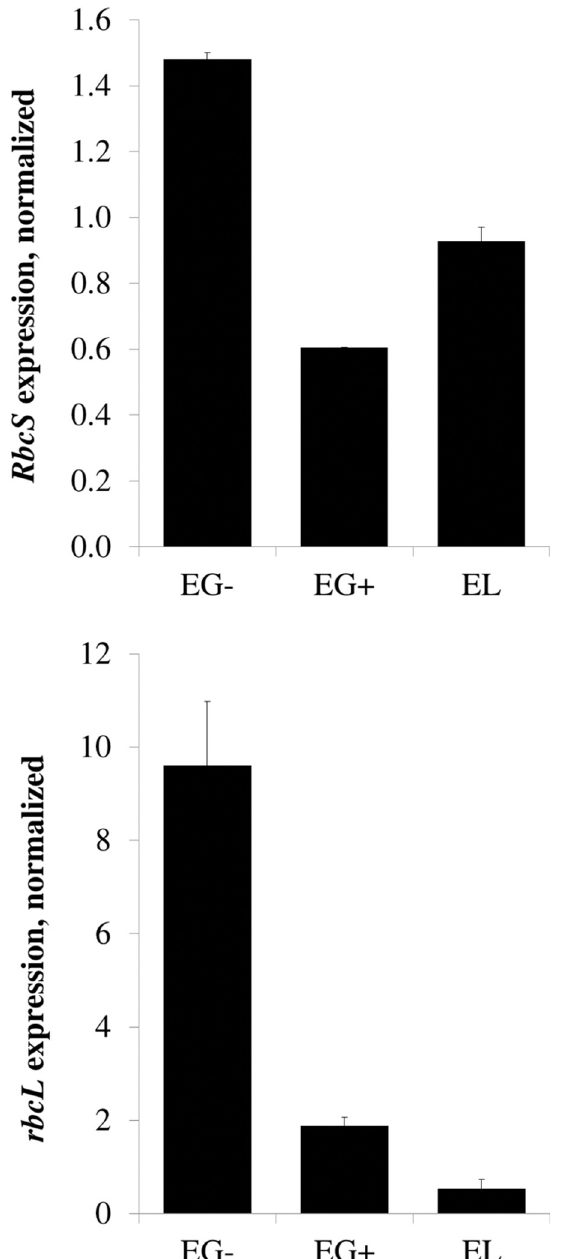
Fig 3. Expression of the RbcS and rbcL genes in Euglena gracilis and Euglena longa . Expression levels of RbcS and rbcL mRNAs were analyzed by quantitative RT-PCR and normalized over the 18S ribosomal RNA. Cultivation conditions and species are denoted as in Fig